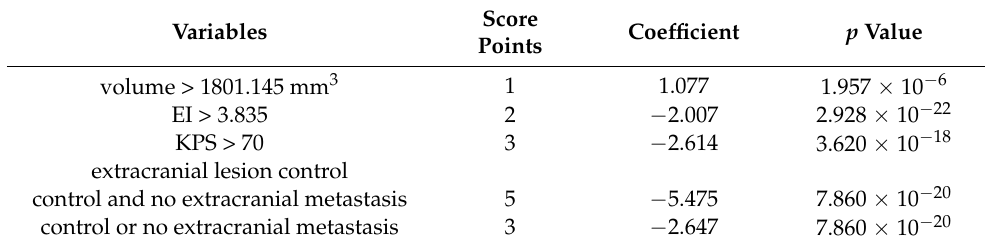
Table 3. Scoring model and results of the regression analysis.